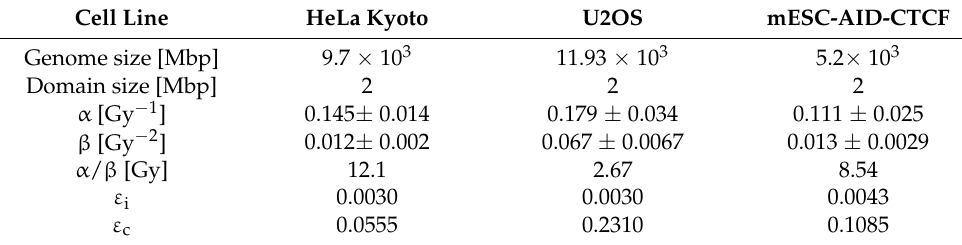
Table 1. Parameters that were used in the GLOBLE model for prediction of the impact of CTCF depletion. The linear-quadratic parameters α and β and the corresponding lethalities ε i and ε c were determined from the survival curves under GFP KD conditions, after pooling all biological replicates. The genome size of Hela Kyoto was taken from [60] and that of U2OS estimated from that value multiplied by the genome size ratio in Figure 1b. The genome size for mouse mESC-AID-CTCF cells was taken from [63] (see Section 2.6). The default domain size was chosen to be identical for all cell